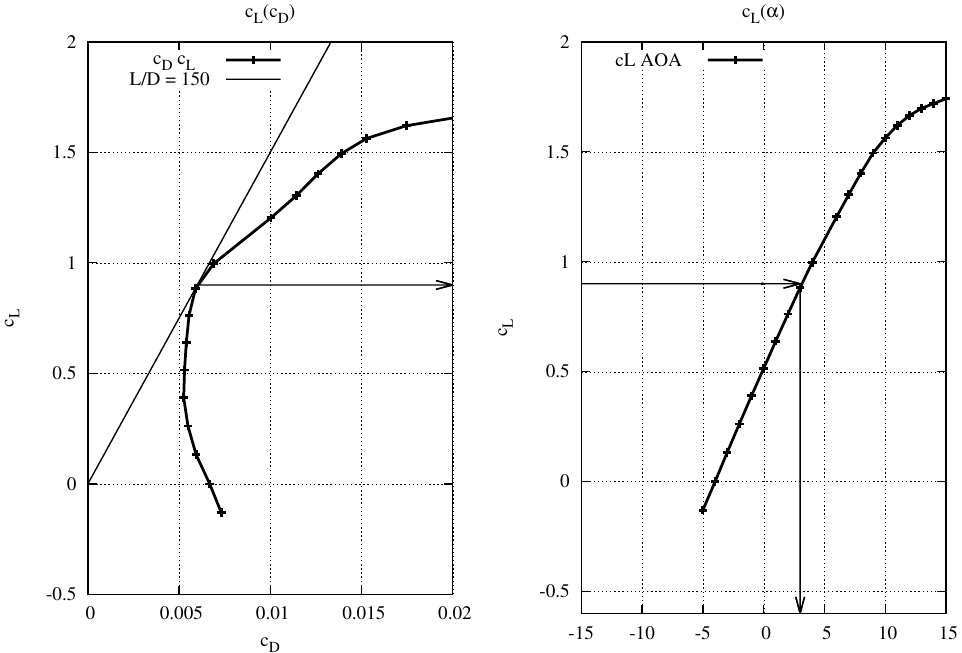
Figure 9. Lilienthal polar of the profile at the location of the glove (Reynolds number, four million). Left side: Lift versus drag. Right side: Lift vs angle-of-attack A so-called laminar nose, a region of small drag c d < 0.008, is clearly visible. Arrows indicate the determination of the operation point using a tangent. N-factor was set to 3. By Mack’s correlation, this corresponds to an inflow turbulence of 0.7%. We assume this to be the aerodynamic relevant part of the whole tubulence spectrum.